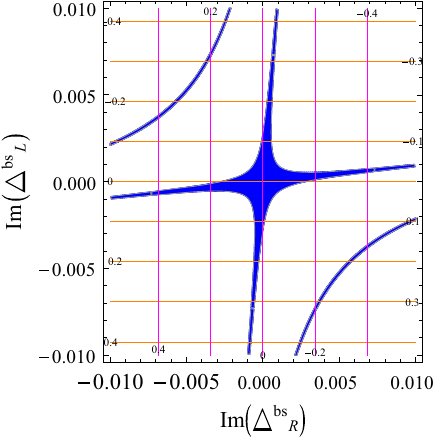
) (Re ( ˜ C Z (cid:3) ) ) in green ( blue ) malized by the SM Wilson coefficient C SM 7 9 in the to the case Re ((cid:5) sb 9 ) = Im ((cid:5) sb ) = 0. regions are allowed from the bounds on (cid:5) M B R L ) (Im ( ˜ C Z (cid:3) ) ) in orange ( magenta ) color nor- 7 9